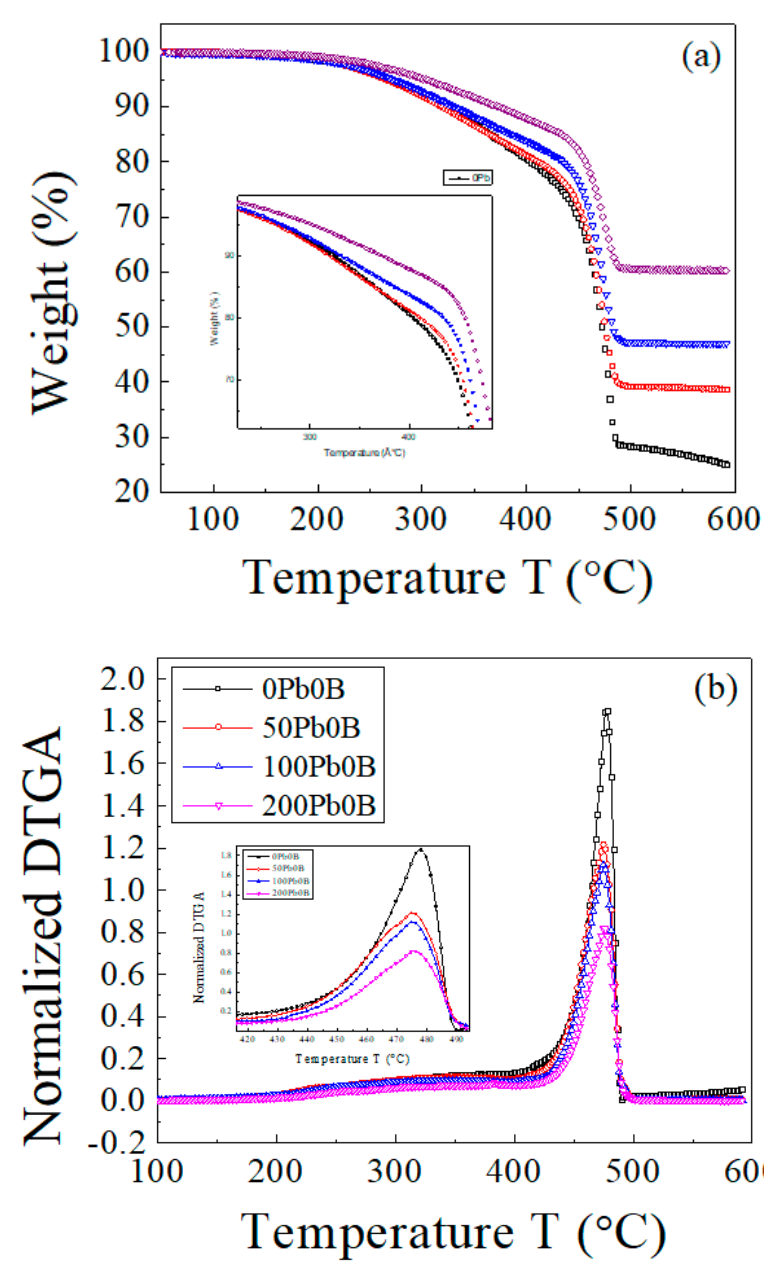
Figure 1. The TGA and DTGA curves of EPDM host composite (0 phr lead) and samples loaded with 50, 100, 200 phr lead. Scanning rate, 10 °C min − 1 . ( a ) TGA curves; ( b ) DTGA